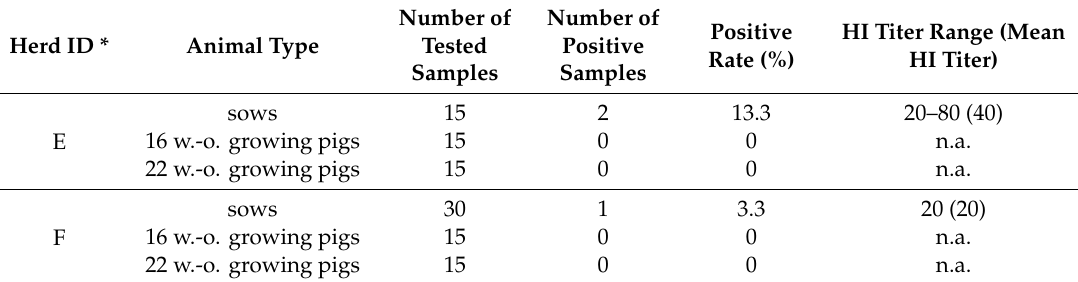
Table 3. Results of swine influenza D virus hemagglutination inhibition (HI) tests performed on sera sampled in herds E and F ( Bretagne ) in March